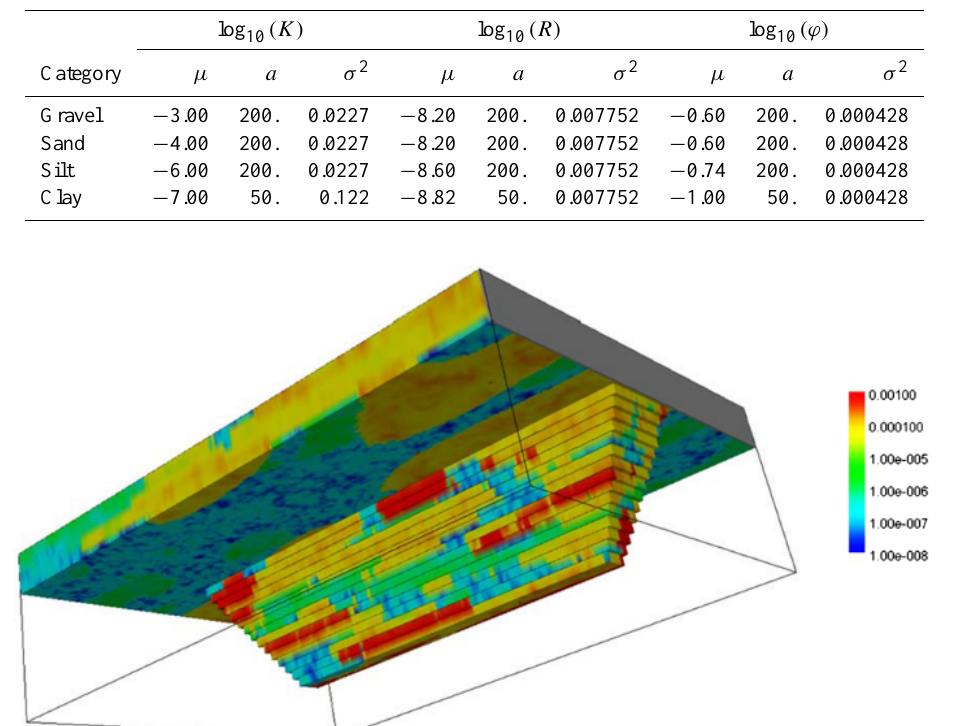
Table 1. Geostatistical parameters for stochastic hydraulic field employed by the hydraulic reference model. K is for hydraulic conductivity (ms − 1 ) , R is for recharge (ms − 1 ) to the groundwater model, and phi for porosity. µ is mean value to the log 10 of K , a is range for small-scale variability, and σ 2 the sill. The semivariograms are exponential.